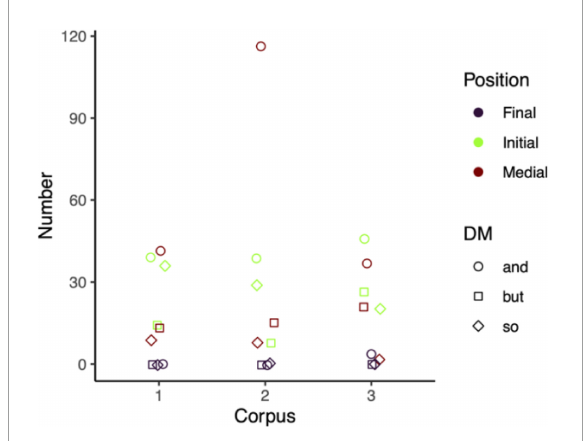
FIGURE6 The positional distribution of the three DMs in the three corpora. (1-the Chinese Corpus, 2-the US Corpus, 3-the UK